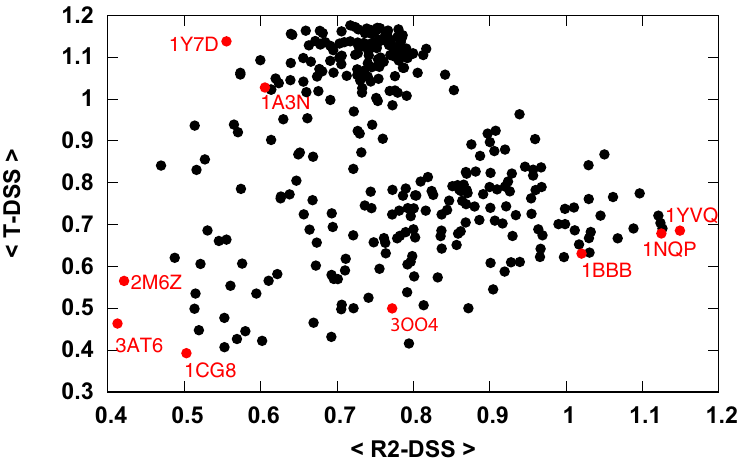
Fig 4. Hemoglobin dynamics similarity map to the T- and R2 states. The abscissa and the ordinate represent the average dynamics similarity score from the R2 and T states.